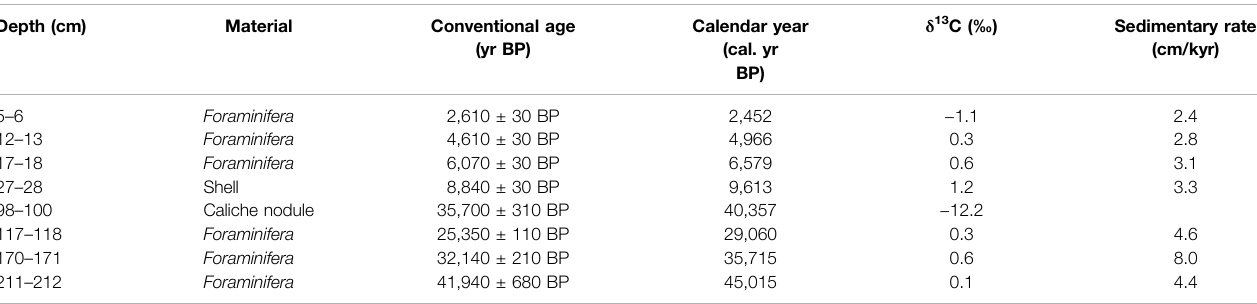
TABLE 1 | AMS 14 C dating and stable carbon isotopic ( δ 13 C) data of the H10 core. Depth